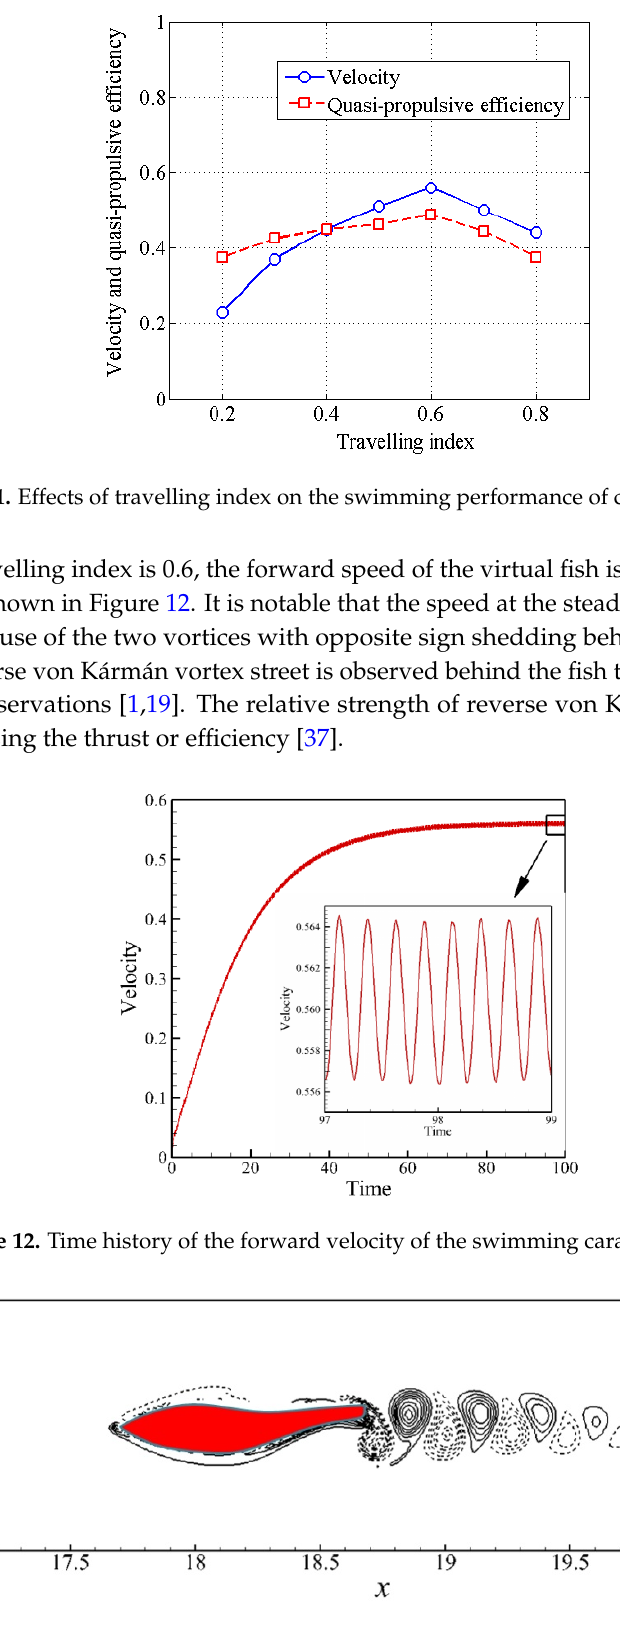
Figure 13. Reverse von Kármán vortex street behind the tail of swimming carangiform fish (solid and dashed lines represent positive and negative values of vorticity, respectively).